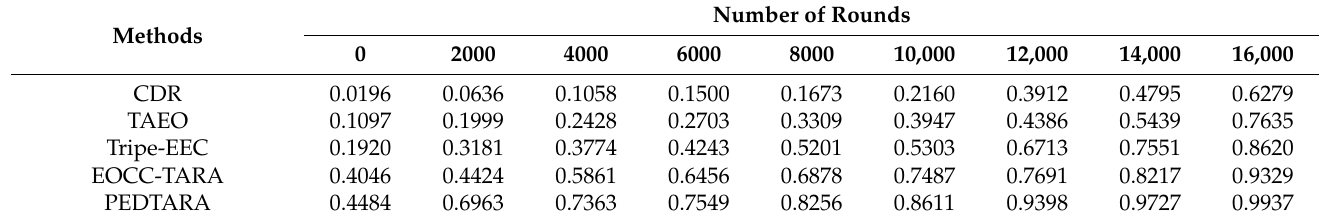
Table 6. Residual Energy (J).